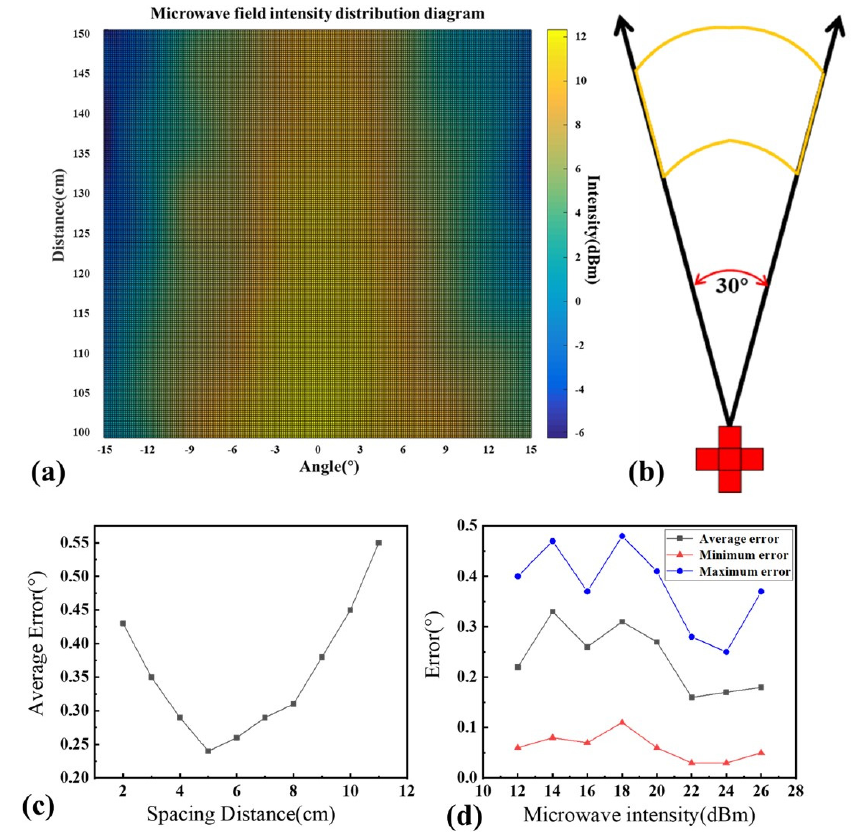
Figure 5. Test result diagram of microwave source direction. ( a ) Test results of antenna microwave field intensity distribution. ( b ) Microwave source direction measurement position and detectable range diagram. ( c ) The average error of the angle detection of the collected data at different distances of the five-point cross position. ( d ) Average error curve, minimum error curve, and maximum error curve of di ff erent microwave emission intensities at a distance of 5 cm.